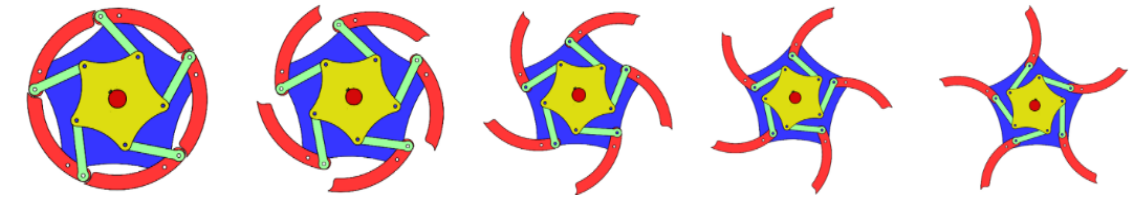
Figure 4. Animation of the mechanism that provides movement to the fingers.